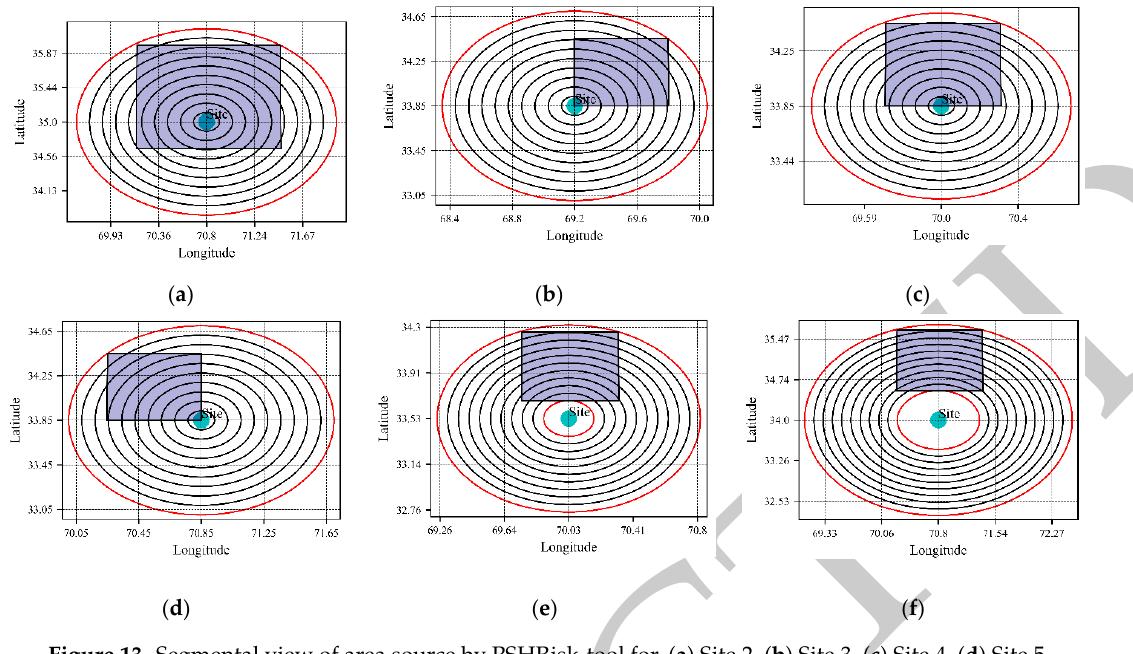
Figure 13. Segmental view of area source by PSHRisk-tool for, ( a ) Site 2, ( b ) Site 3, ( c ) Site 4, ( d ) Site 5, ( e ) Site 6, ( f ) Site 7